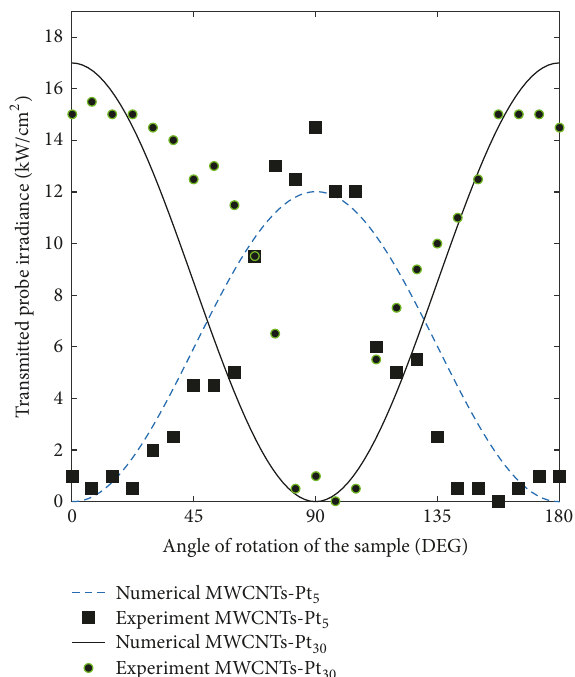
Figure 4: Transmitted probe irradiance in the double-stage OKG with rotating samples.